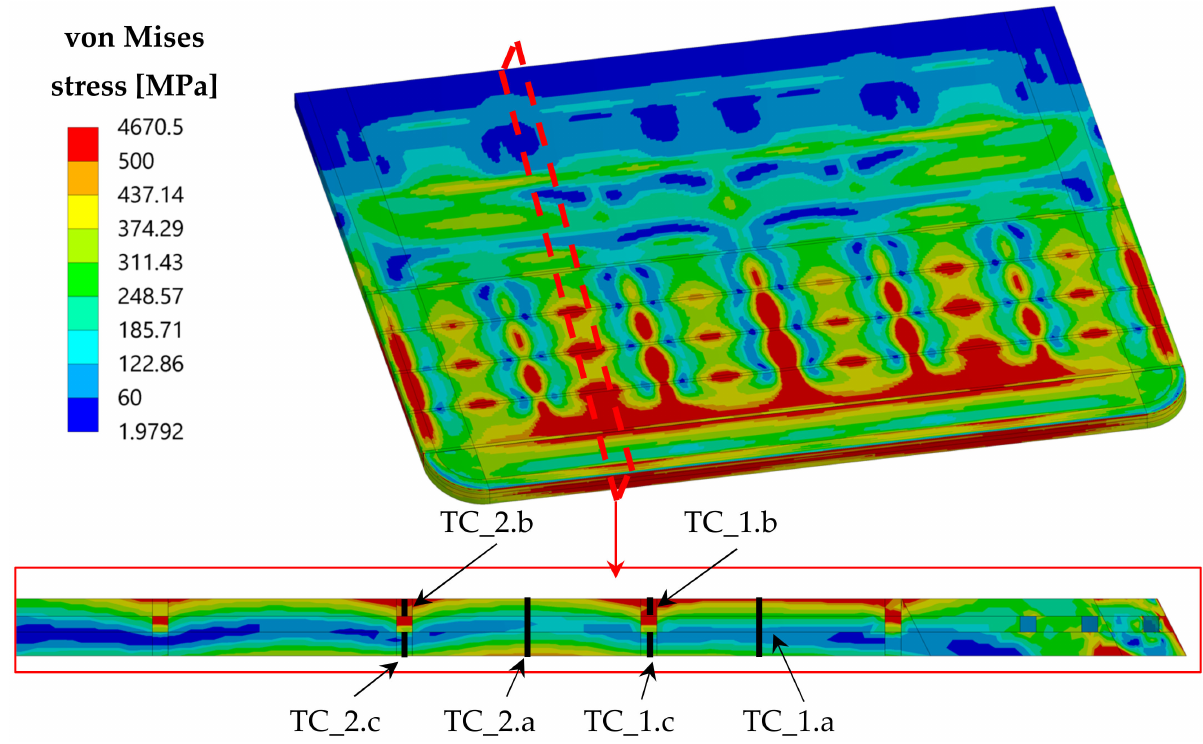
Figure 8. OP von Mises equivalent stress field and path locations within TC